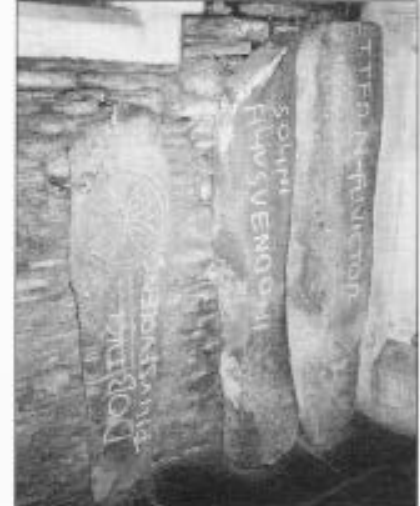
Figure 1 Three Welsh memorial stones of fifth-or sixth-century AD date from the churchyard atClydai, Pembroke shire, with vertical Latin inscriptions, although those at either end of the row are bilingual, with additional ogham inscriptions (the cross on the left-hand stone was added later).